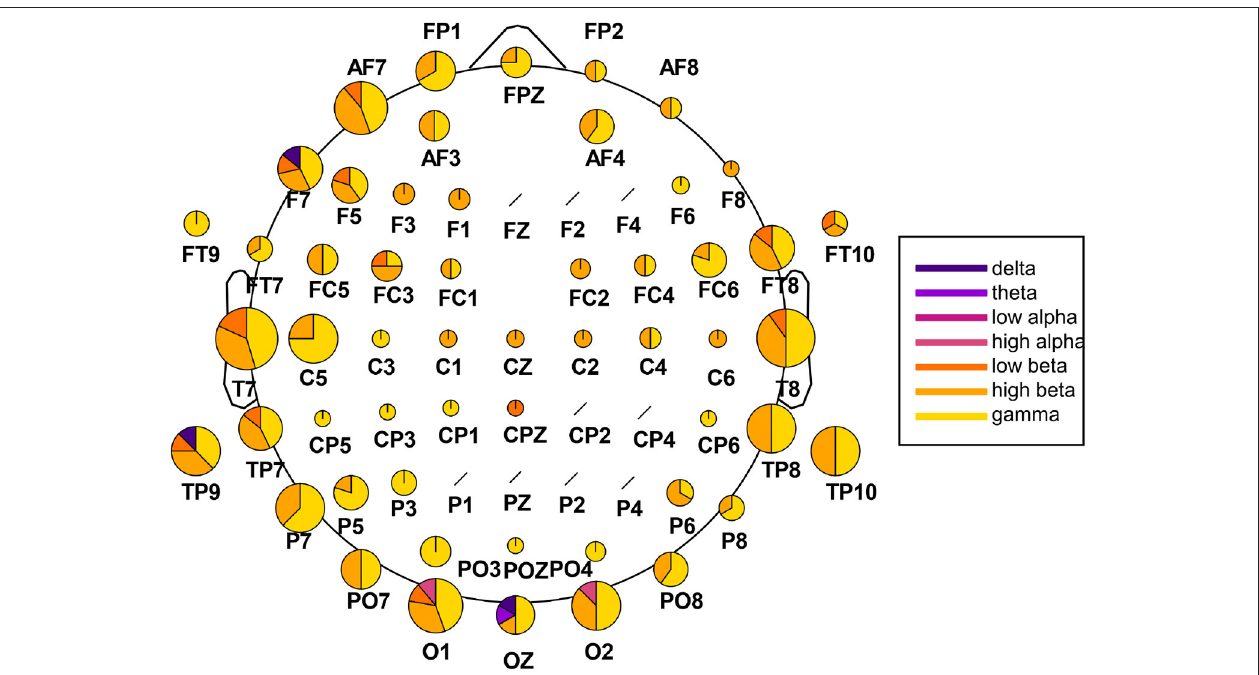
FIGURE 5 | Extraction of the highest-ranked features for classification from the time-frequency analysis. The analysis was carried out across participants, with 220 features in total (20 per participant). The size of the channel-specific pie plot reflects how often the respective channel occurred in the main features. The pie plots’ distribution indicates the relative amount of features from each frequency band,ranging from delta (dark violet) to gamma (yellow). Channels marked with a black slash did not occur in the main features.